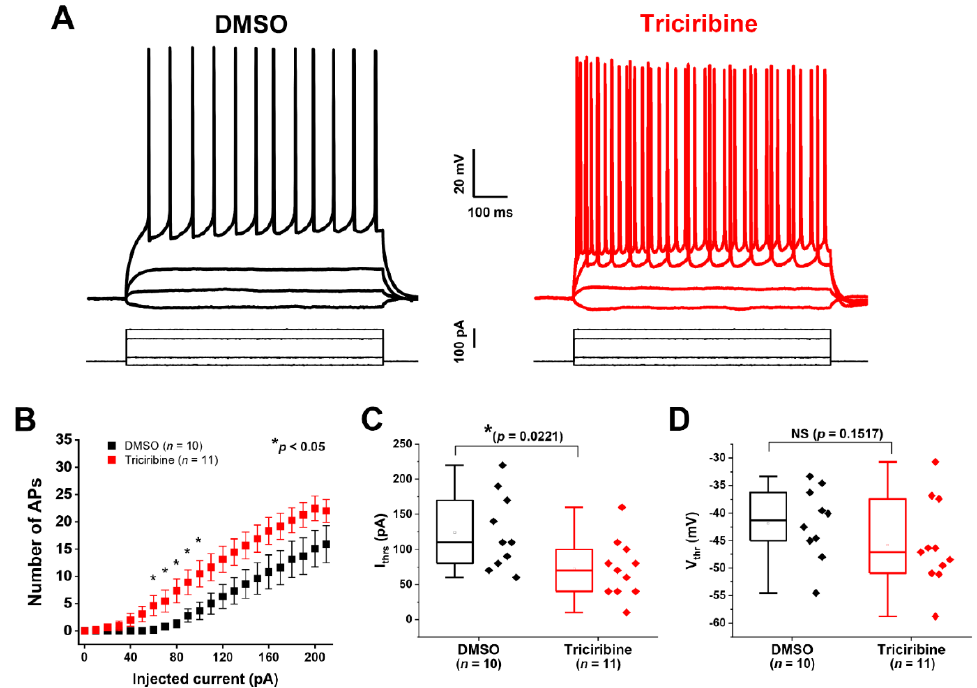
Figure 3. Akt inhibition increases excitability in CA1 hippocampal pyramidal neurons. ( A ) Repre- sentative traces showing trains of evoked action potentials recorded from CA1 pyramidal neurons treated for 60 min with either DMSO (black) or 20 µM triciribine (red) in response to increasing current injections from − 20–210 pA (schematic of the current-clamp protocol is shown below repre- sentative traces). ( B ) Input–output curve showing increase in number of spikes in triciribine treated CA1 pyramidal neurons. Akt inhibition significantly increases the number of spikes across a broad range of injected currents. ( n = 10 in DMSO and n = 11 in triciribine treated group; mean ± SEM, * p < 0.05 with Student’s t -test.) ( C ) Graph showing the effect of Akt inhibition on action potential current threshold. A 60 min treatment with triciribine significantly reduces the current threshold in CA1 pyramidal neurons. ( n = 10 in DMSO and n = 11 in triciribine treated group; * p = 0.0221 with Student’s t -test). ( D ) Graph showing the effect of Akt inhibition on action potential voltage threshold. Treatment with triciribine did not affect voltage threshold in CA1 pyramidal neurons. p = 0.1517 with Student’s t -test. Box plot shows: Range (Perc 25, 75), Mean, Median, Min, and Max. Results with additional parameters are summarized in Table 3. Table 3. Effects of triciribine on active and passive properties of hippocampal CA1 pyramidal neurons a .